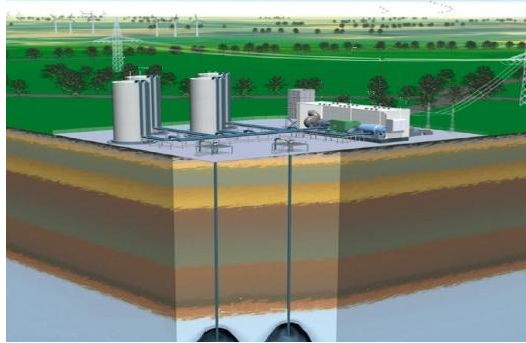
Figure 15. Visualization of the ADELE storage plant [61].